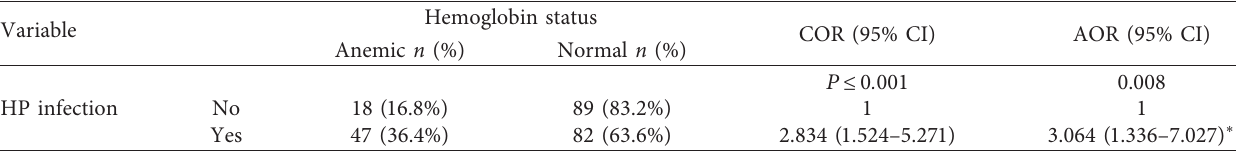
Table 5: The relationship between anemia and HP infection among study participants in Kulito Health Center, SNNPR, Ethiopia, 2018 ( n �